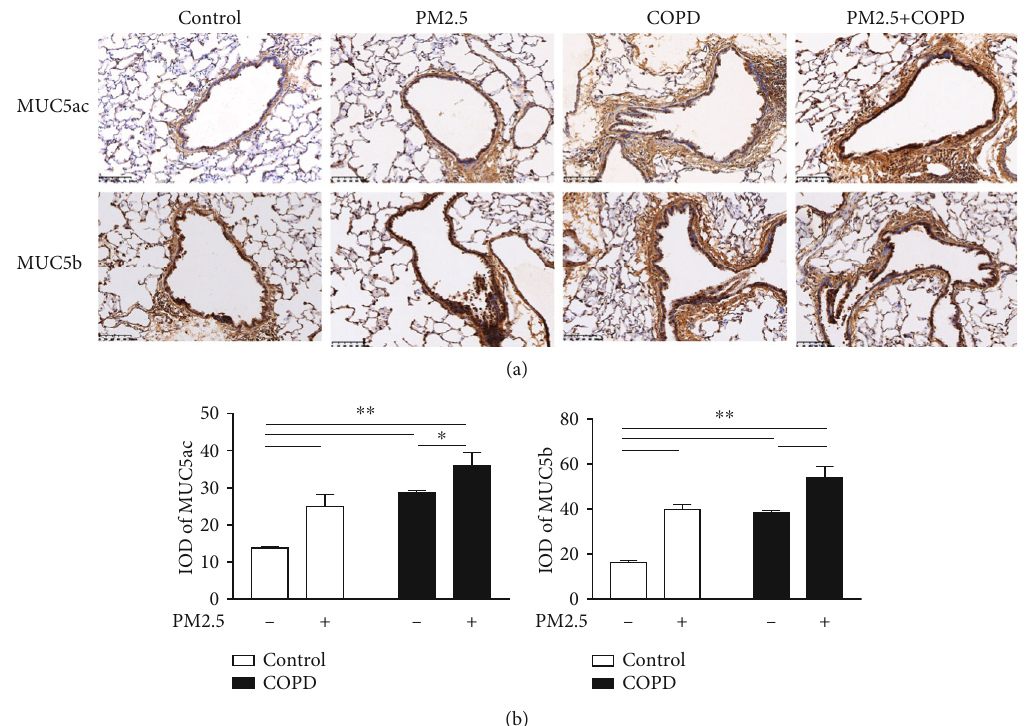
Figure 7: The e ff ect of PM2.5 exposure on mucus hypersecretion in rats with COPD. (a) Immunohistochemical staining of MUC5ac and MUC5b in the lung sections of each group (magni fi cation, × 200). (b) Quantitative analysis of MUC5ac and MUC5b using Image- ProPlus 6.0 software. MUC5ac: Mucin5ac; MUC5b: Mucin5b; IOD: integral optical density. The data are expressed as the means ± SD ( n = 6 ). ∗∗ p < 0 : 01 , ∗ p < 0 : 05 .